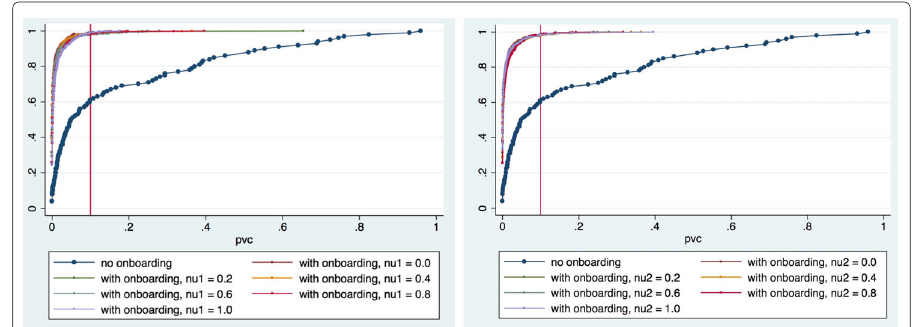
Fig. 5 Cumulate Density Functions of p -values returned by goodness-of-fit tests to the (best-fit) power-law models for in-degree distributions of the interaction networks in the control and treatment groups. Sixty percent of the networks evolved without onboarding ( darkblue ) have degree distributions that test negatively for H1. When onboarding is introduced, that percentage rises to almost 100%. On the left figure, the treatment group interaction networks have been grouped according to the value taken by ν 1 ; on the right , they have been grouped according to the value taken by ν 2